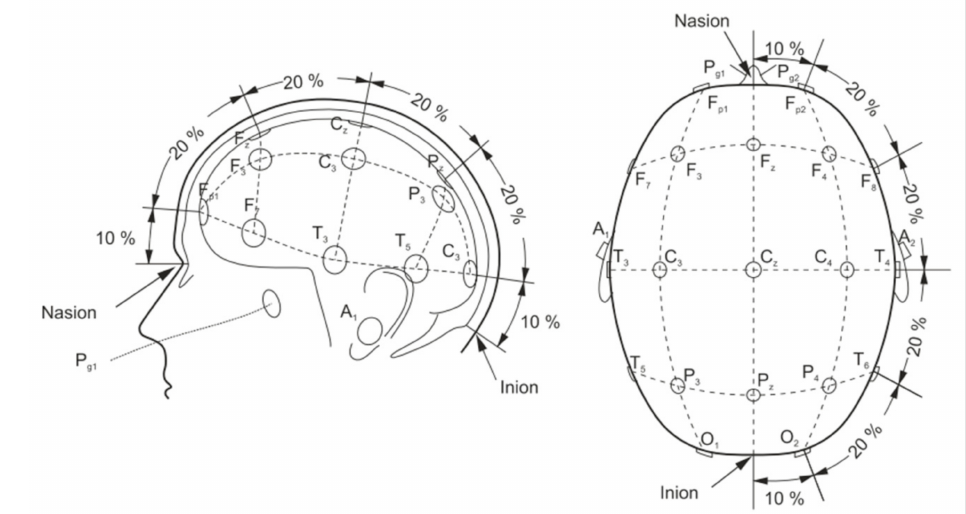
Figure 4. Electrode placement over scalp according to the international 10–20 system